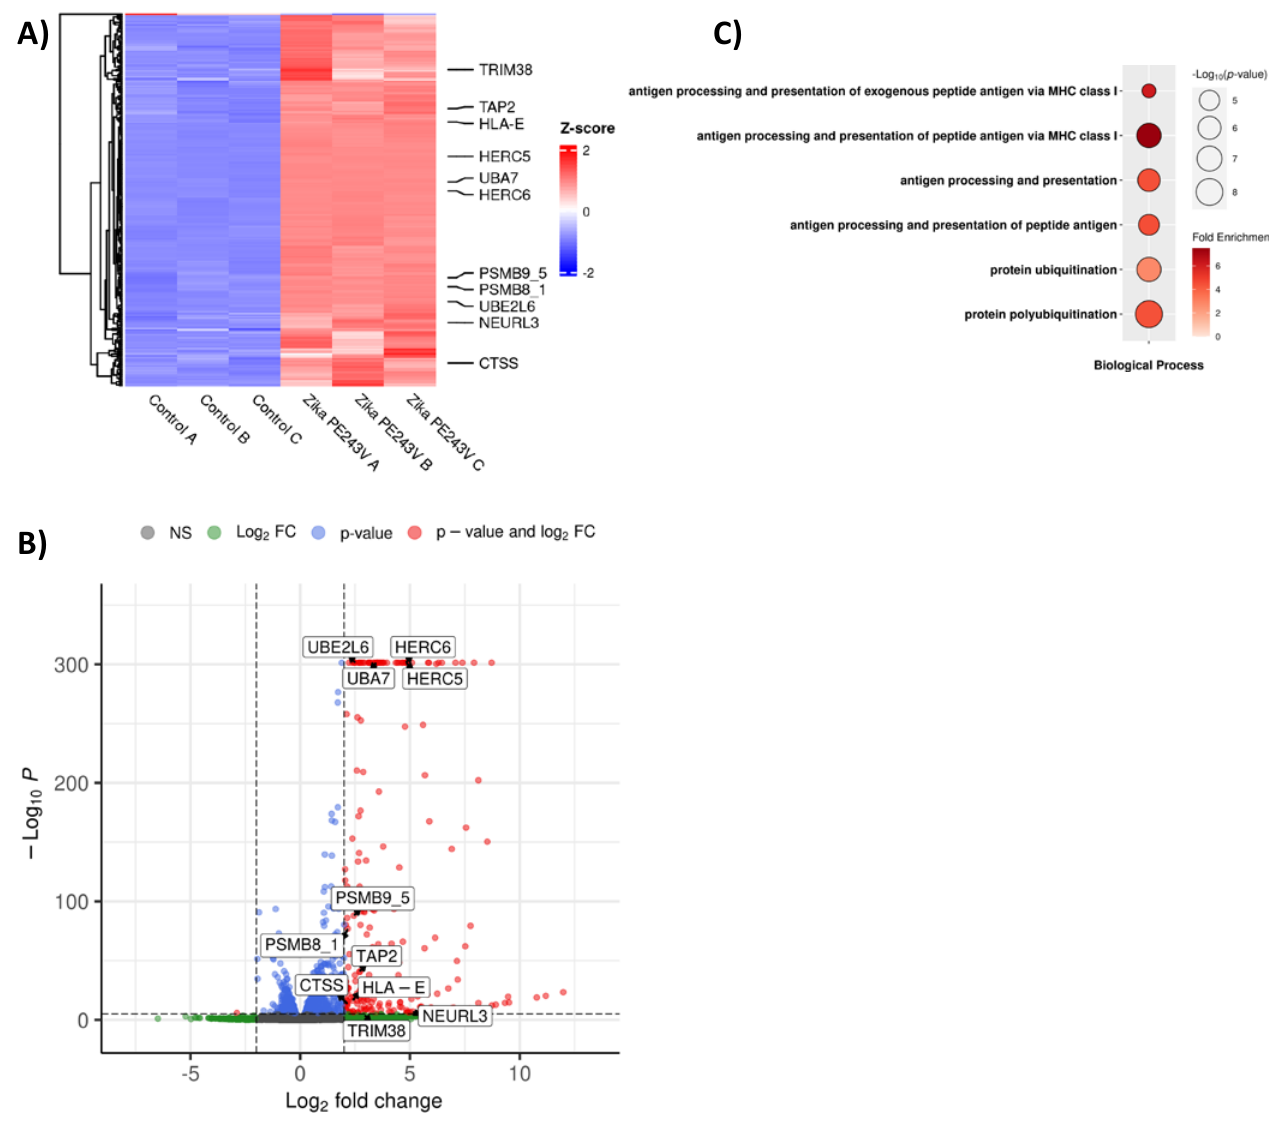
Figure 6. ZIKV downregulates miRNAs to increase ubiquitination and antigen presentation. ( A ) Heat- map, ( B ) Bubble plot of gene ontology, and ( C ) volcano plot of public RNA-sequencing from hiNPCs (n = 3). 31,040